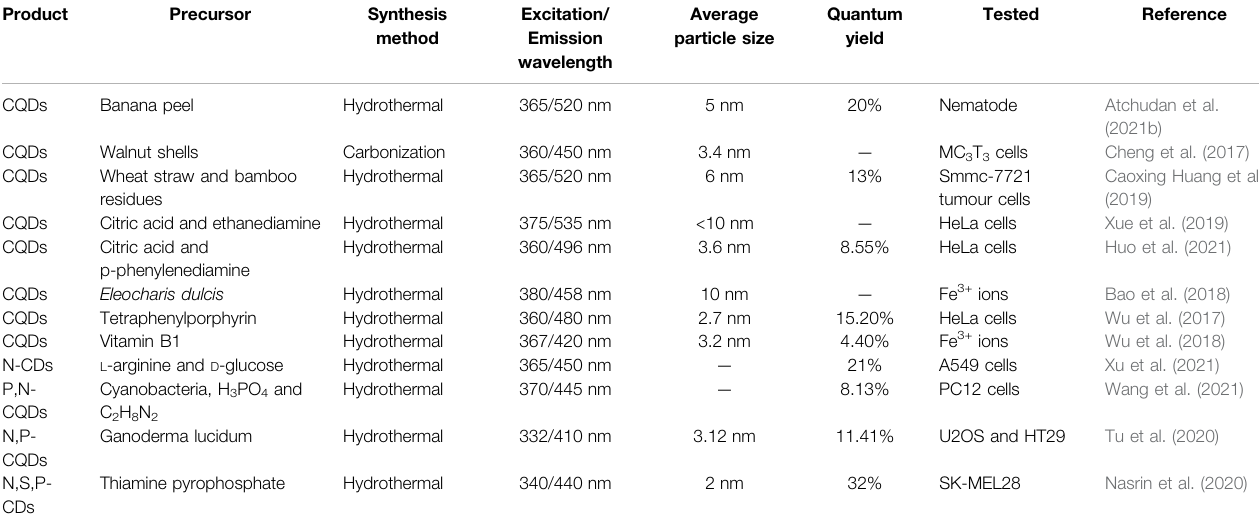
TABLE 2 | Synthesis of CQDs from various organic and inorganic precursors for bio-imaging applications and their noticeable parameters of Ex/Em wavelengths, average particle size, and